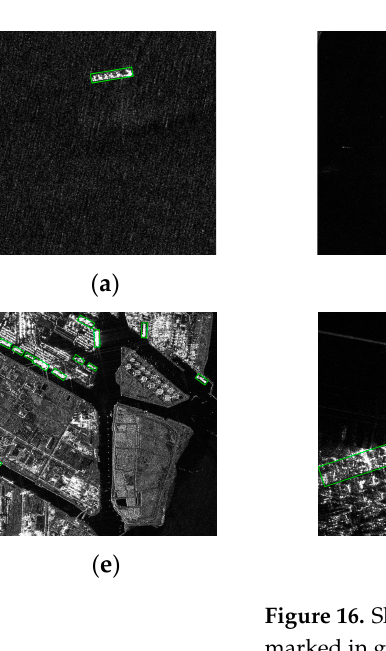
Figure 15. The ship annotation. ( a ) The OBB label in a SAR image; ( b ) the xml label file annotated by RoLabelImg. Each ship target is represented by an oriented bounding box as its ground truth. Where ( cx , cy ) is the centroid, w and h denote the width and height, and θ indicates the rotation angle; ( c ) the txt label file in DOTA format. Each ship is represented by four ordered vertices. Note that the top-left vertex is taken as the starting point, and the four vertices are arranged in clockwise order.